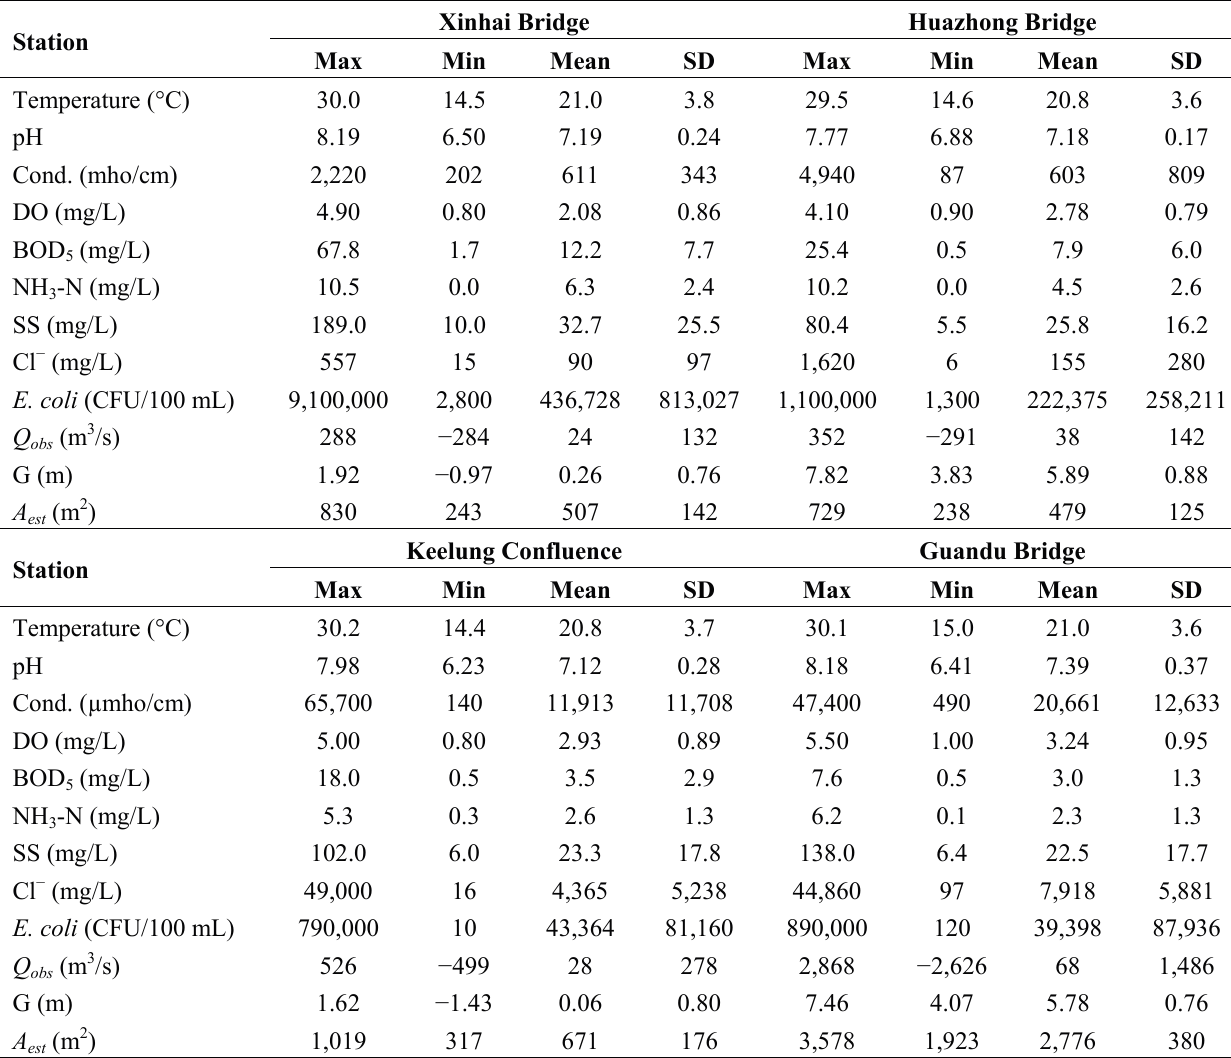
Table 1. Descriptive statistics of the water quality analysis results for each station. DO, , the biochemical oxygen demand in 5 days; SS, suspended solids; dissolved oxygen; BOD 5 , observed discharge; G, water Q obs